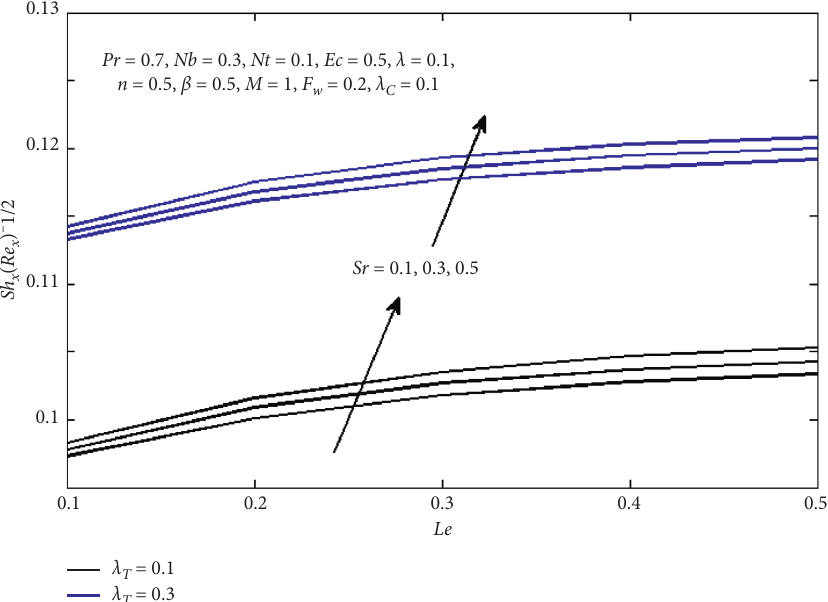
Figure 26: Variation of Sh